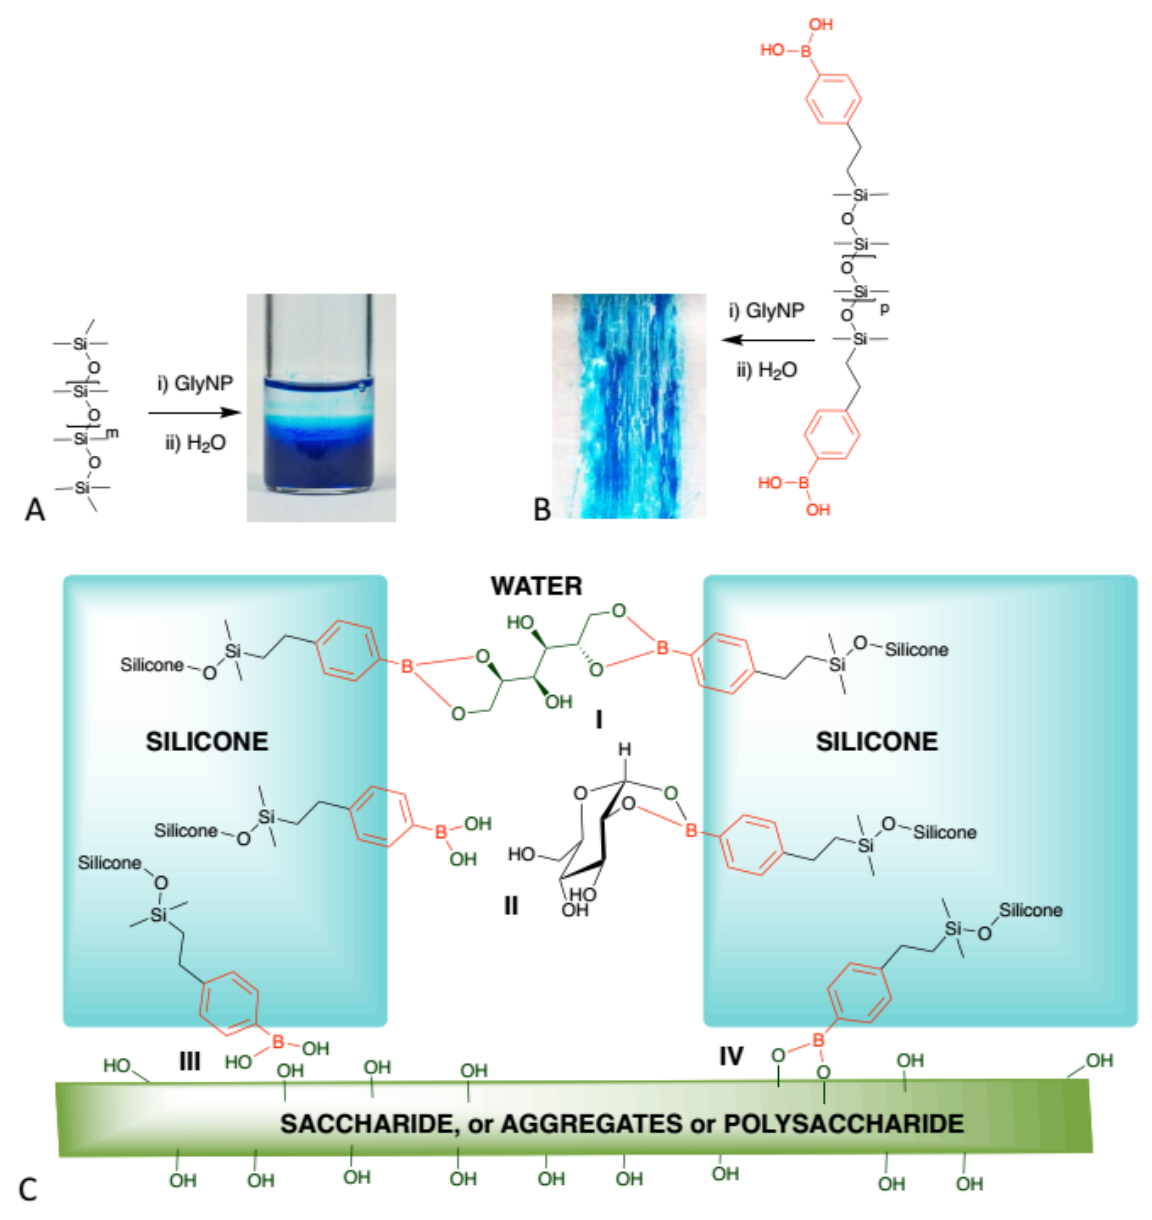
Figure 5. Synthesis of silicone elastomers by cross-linking of phenylborate groups in organic PBSs with saccharides: addition of an ordinary siloxane with phytoglycogen and 35 nm spherical monodisperse nanoparticles (GlyNP) to water (A); addition of siloxanes with phenylborate terminal groups results in a dispersion (B); formation of elastomers with sorbitol (C). Reprinted with permission from [78]. Copyright 2022 Royal Society of Chemistry.